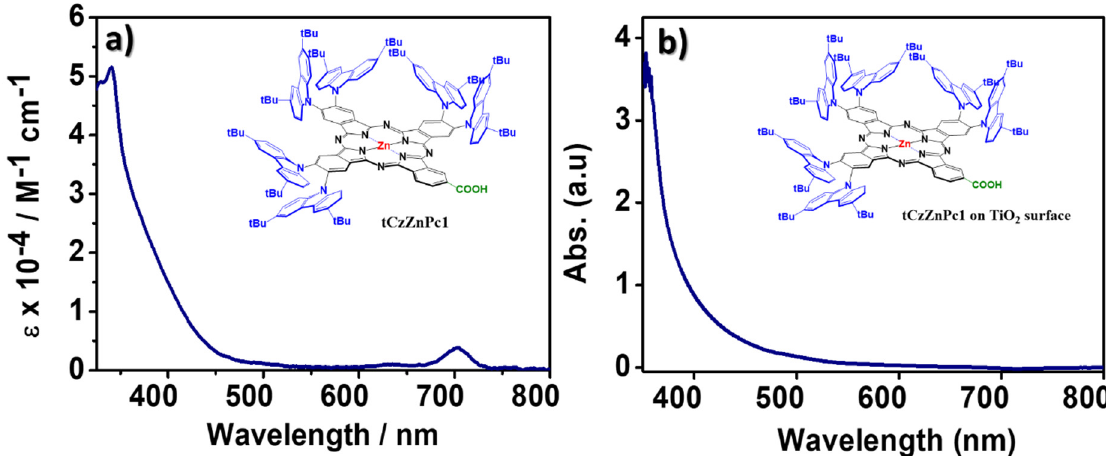
Figure 4. ( a ) Absorption in solution tCzZnPc1 (THF, 25 °C, 10 − 5 M), and ( b ) after adsorption on a 4µm-thick transparent TiO 2 mesoporous electrode.